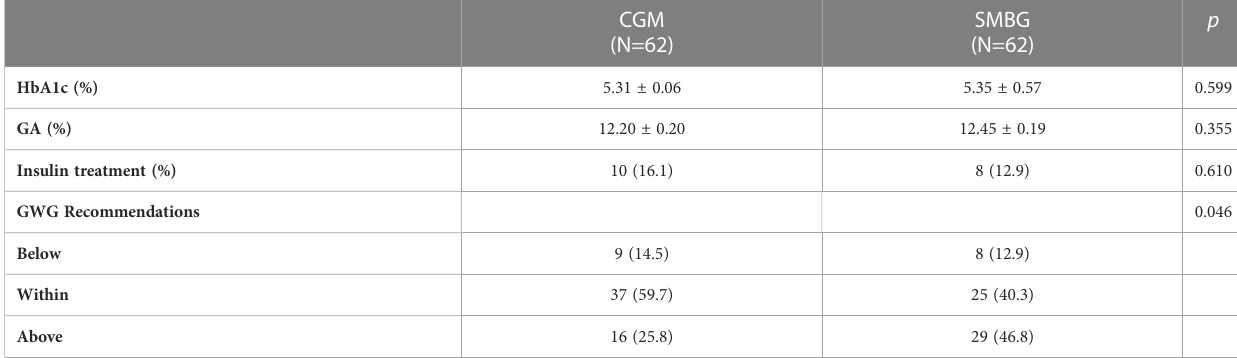
TABLE 3 Glucose levels, treatment and weight control antepartum.